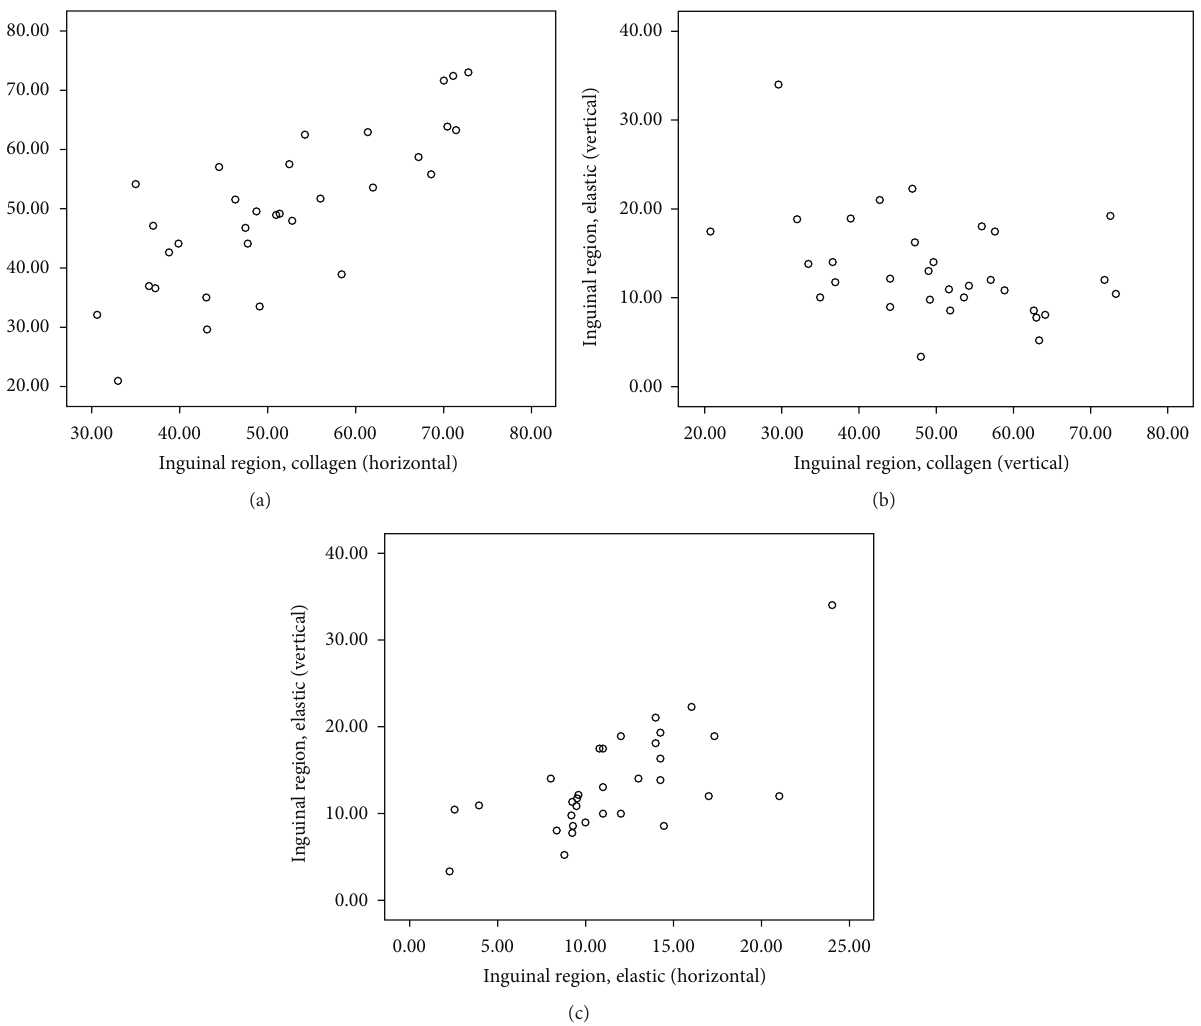
Figure 5: Scatter plot of significant Spearman correlation pattern at inguinal area. (a) Strong positive correlation between C H and C V . (b) Low negative correlation between C V and E V . (c) Moderate positive correlation between E H and E V (C H : collagen in horizontal, C V : collagen in vertical, E H : elastic in horizontal, and E V : elastic in vertical